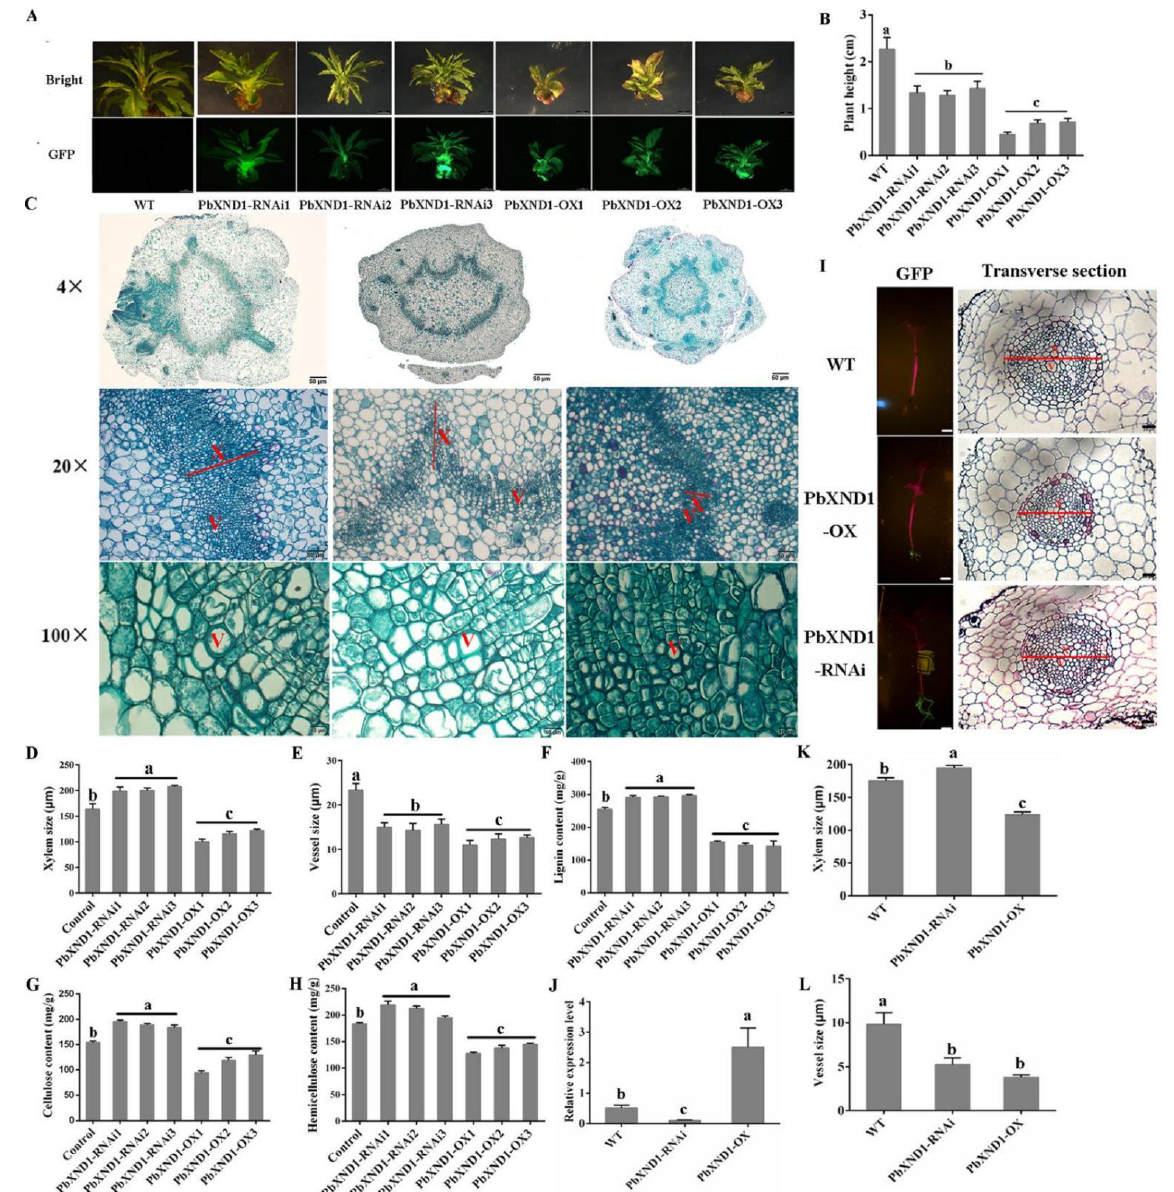
Figure 2. PbXND1 inhibited xylem development in the transgenic pear. ( A ) The growth pheno- types and green fluorescence detection of one-month-old PbXND1 overexpression and silencing pear plants and control plants. Bars, 2 mm. ( B ) Plant height of one-month-old PbXND1 overexpression and silencing pear plants and control plants. ( C ) Cross sections of the stems of pear plants stained with safranin O and fast green. X, xylem; V, vessel. Bars, 200 µm and 50 µm. Data are shown as means ± SD ( n = 3). ( D ) Xylem size of PbXND1 overexpression and silencing pear plants. Data are shown as means ± SD ( n = 3). ( E ) Vessel size of PbXND1 overexpression and silencing pear plants. Data are shown as means ± SD ( n = 3). ( F – H ) Lignin, cellulose and hemicellulose content of PbXND1 overexpression and silencing pear plants. One month-old pear stems as experimental materials. Data are shown as means ± SD ( n = 5). ( I ) GFP and transverse section observation of wild-type (WT), PbXND1-OX and PbTCP4-OX roots. X, xylem; V, vessel. Bars, 20 µm. ( J ) Relative expression of PbXND1 in transgenic pear roots. Data are shown as means ± SD ( n = 3). Different letters denote statistical significance ( p < 0.05). ( K ) Xylem size of pear roots. ( L ) Vessel size of pear roots. Data are shown as means ± SD ( n = 3). Different letters denote statistical significance ( p <